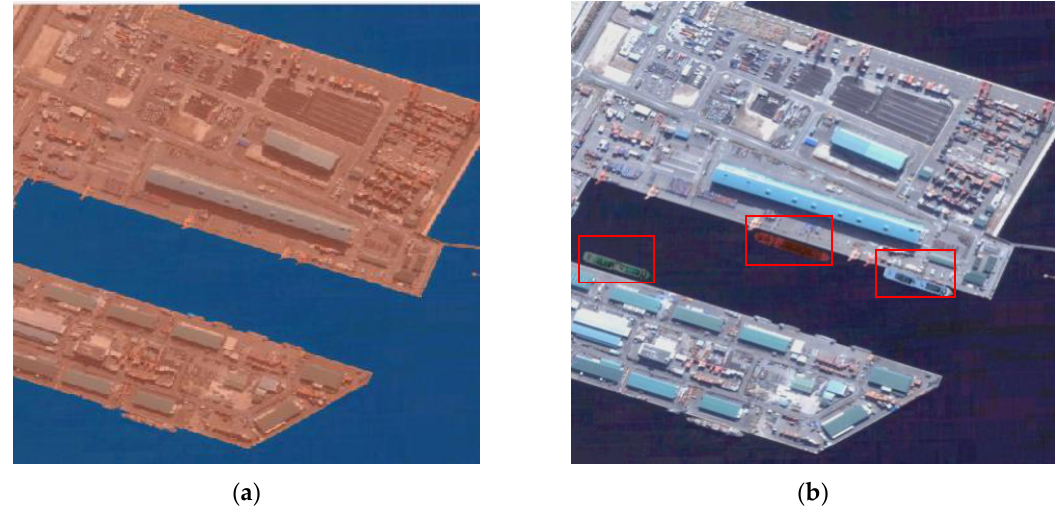
Figure 5. ( a ) Diagram of sea–land segmentation. ( b ) Generated simulation image.